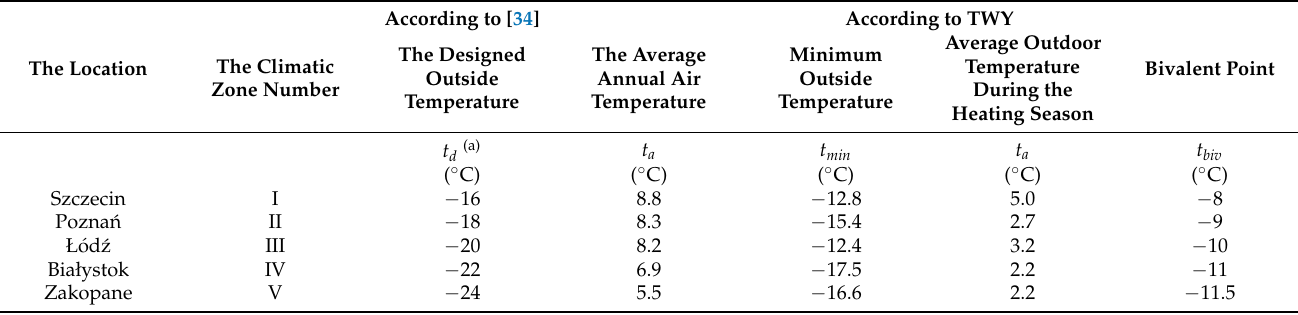
Table 5. The temperatures in the selected